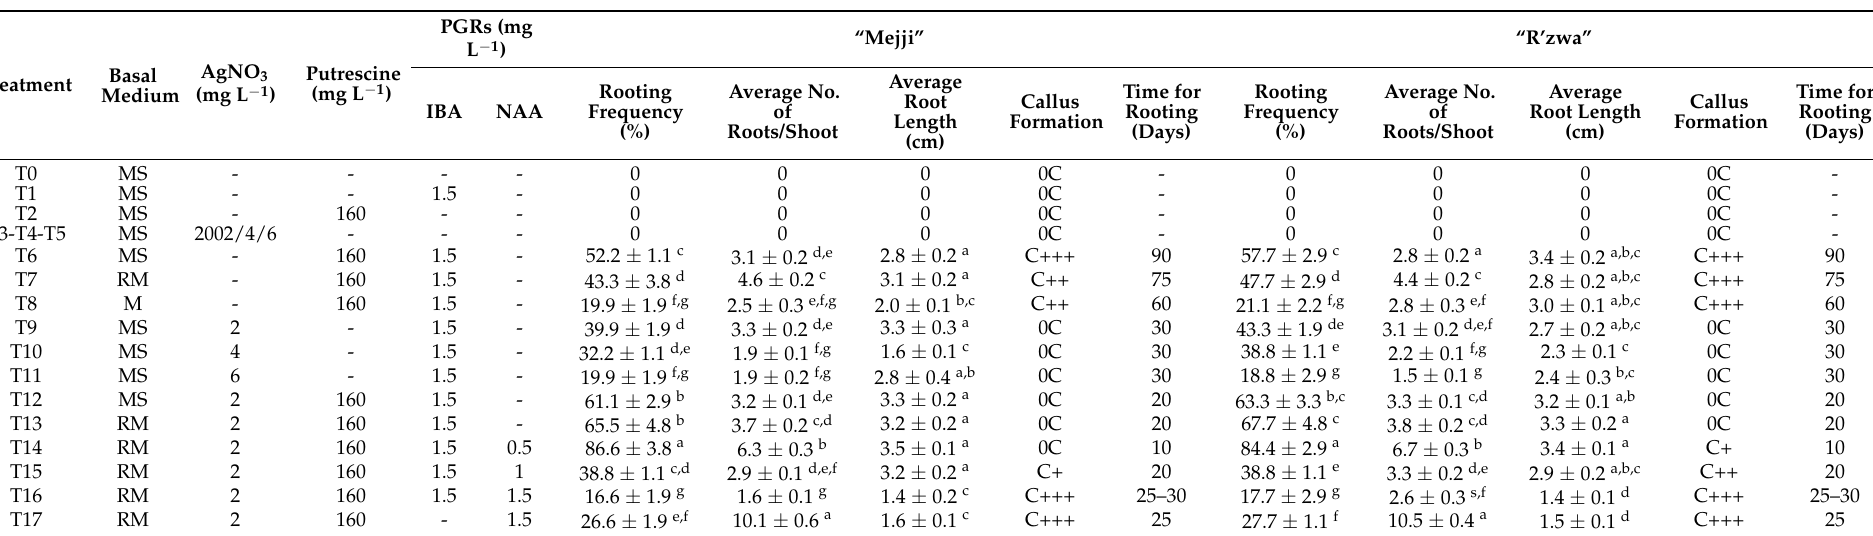
Table 1. Effect of genotype, putrescine, silver nitrate, indole-3-butyric acid (IBA) and 1-naphthalene acetic acid (NAA) on rooting percentage, number of roots per shoot, root length, callus formation and the time required for rooting in two argan ( Argania spinosa (L.) Skeels) genotypes, “Mejji” and “R’zwa”.